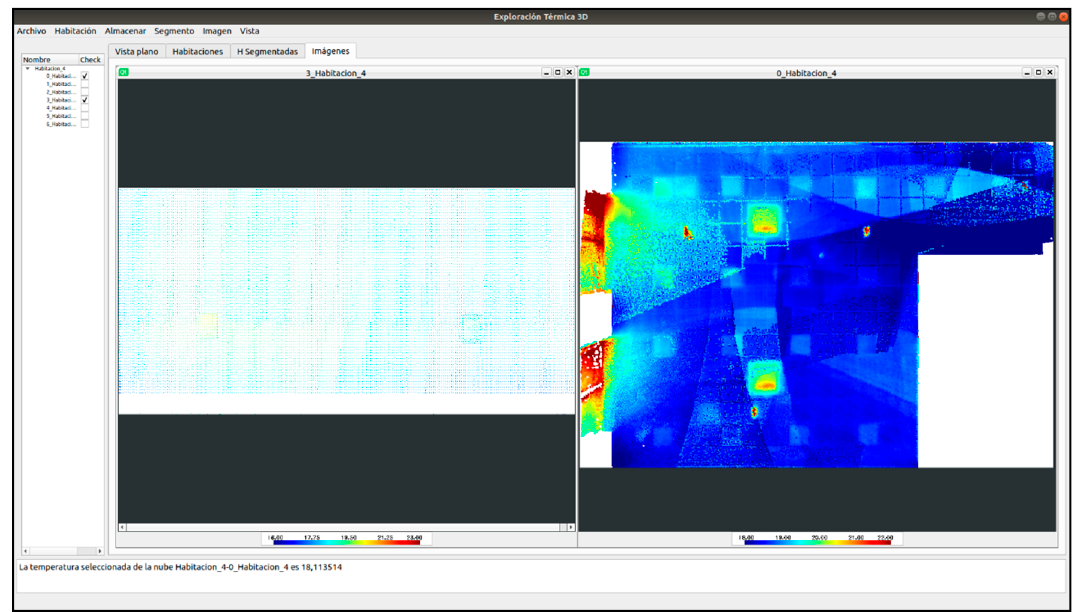
Figure 12. 3D-TTA Module 1: Visualization of two SE orthoimages of the 4-th SE of room #3 and 4-th SE of room #0 (Scenario 1). Note that the filling-hole process has not been applied to the first image.